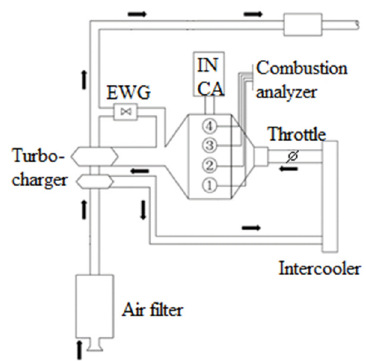
Figure 1. The layout of the engine bench test (The EWG in the figure is the abbreviation of the electrical waste gate).